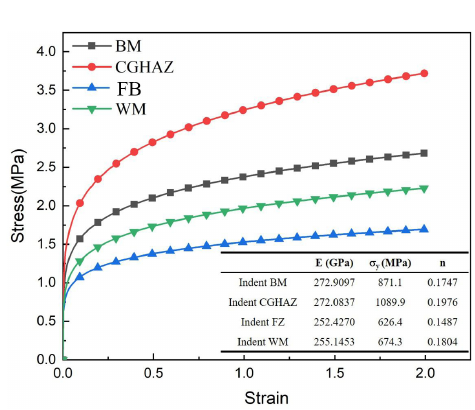
Figure 12. Fracture morphology of weld center. Figure 13. Stress-strain curve of each micro